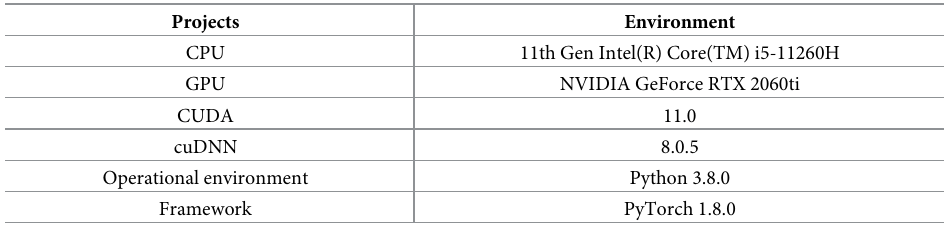
Table 3. Experimental platform